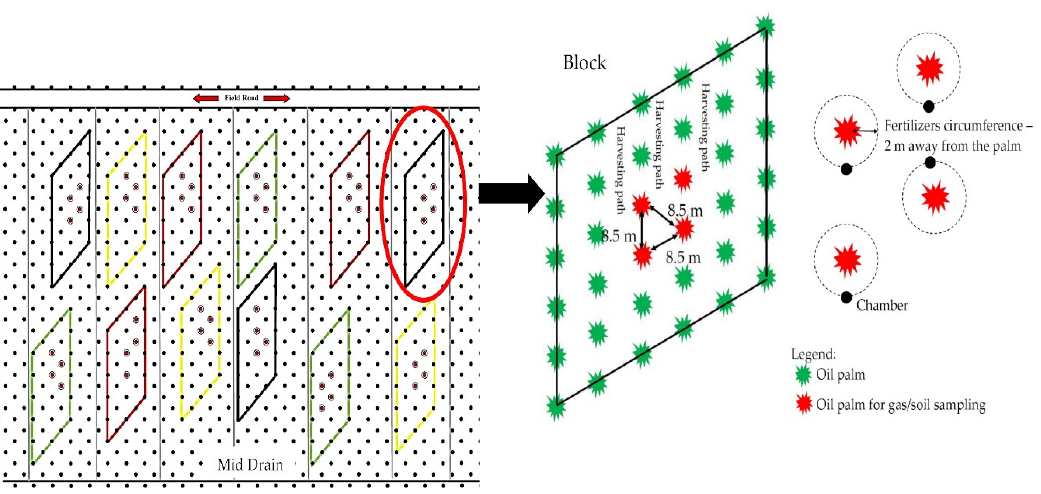
Figure 1. A diagram of the experimental design; each color represents different treatments (black—T1, yellow—T2, red—T3, and green—T4). Table 1. Rate of ammonium sulphate (AS).